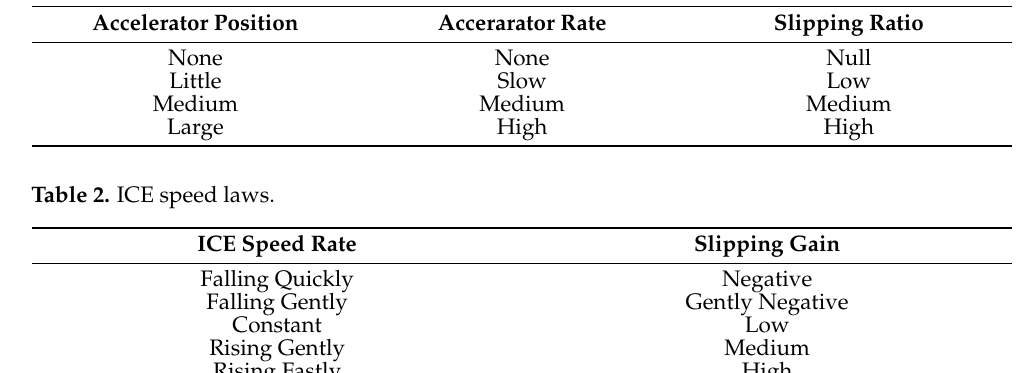
Table 1. Accelerator laws.